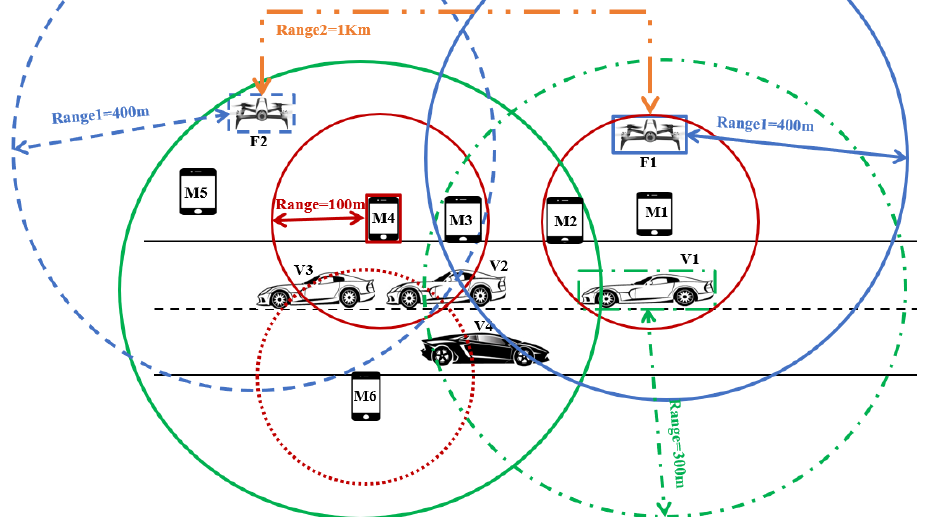
Figure 8. Example of HAdN_MVF